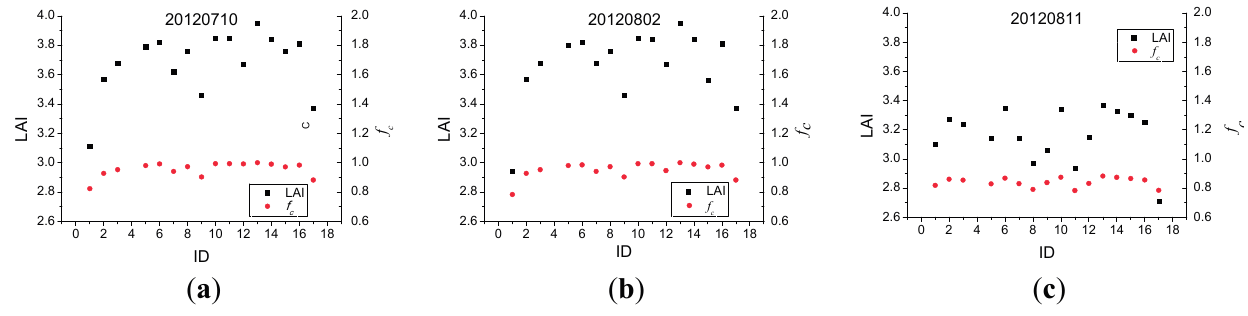
Figure 9. Comparison of the LAI and f c at 17 AMS/EC stations on ( a ) 10 July, ( b ) 2 August and ( c ) 11 August of